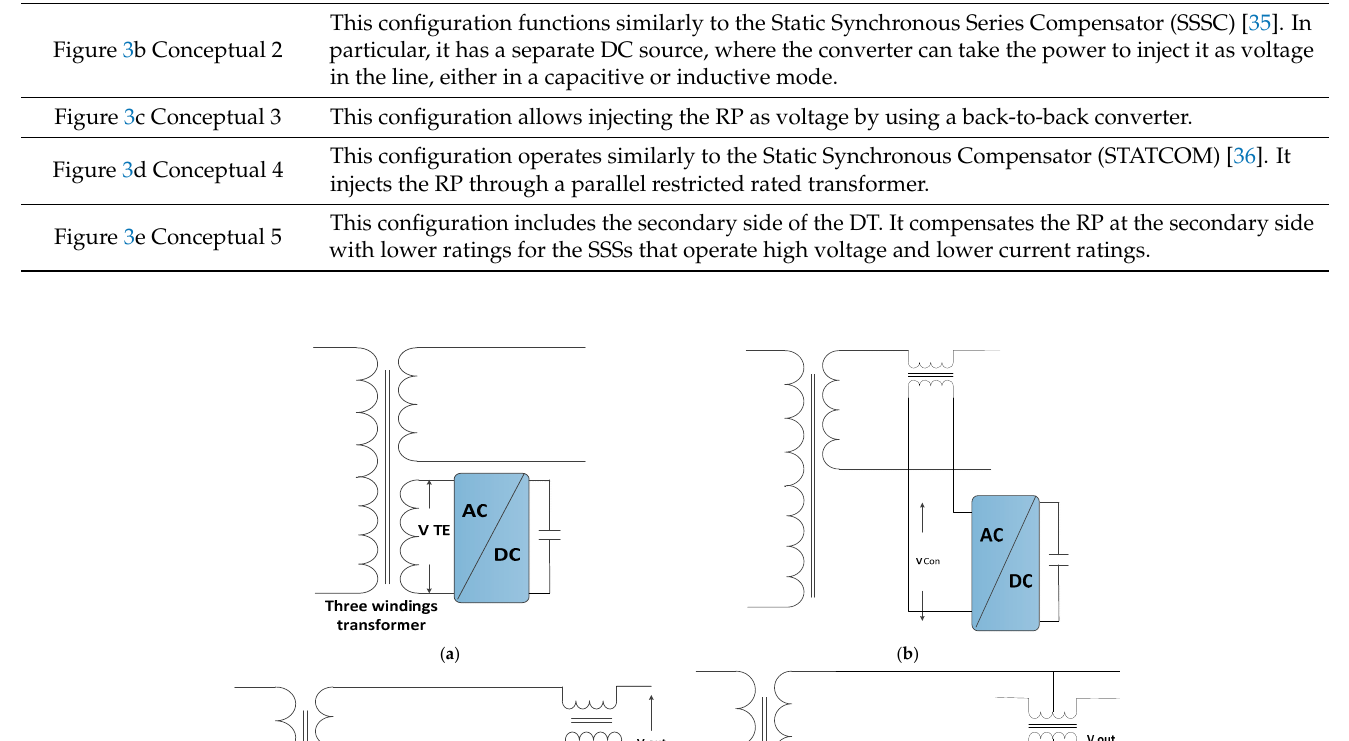
Conceptual Schematics Figure 3a Conceptual 1